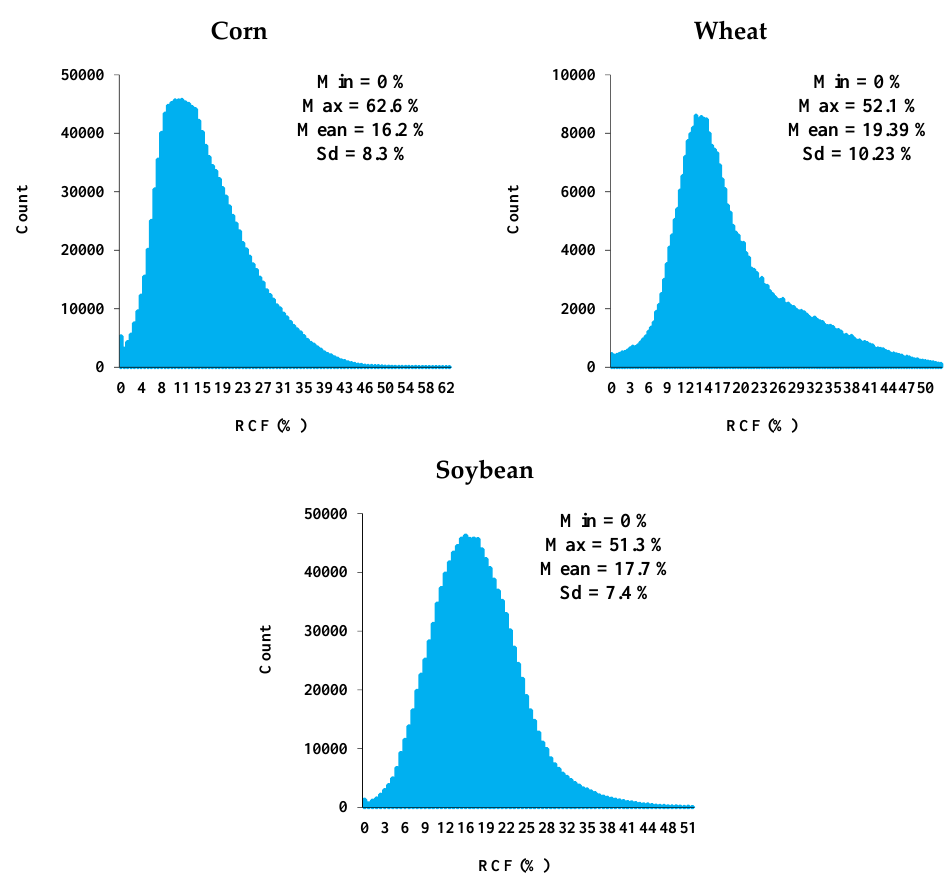
Figure 7. Frequency histogram and statistical parameters of the modeled RCF values of corn, wheat and soybean crops in the study area based on the proposed strategy.